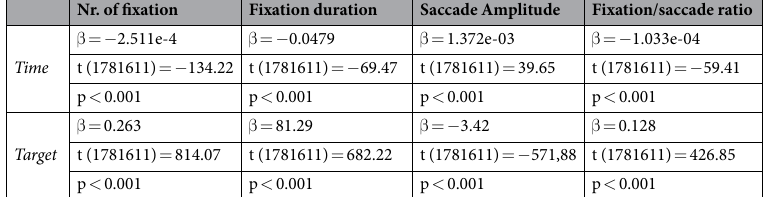
Table 1. Effect of time and target in oculomotor data by using LMEM analysis.